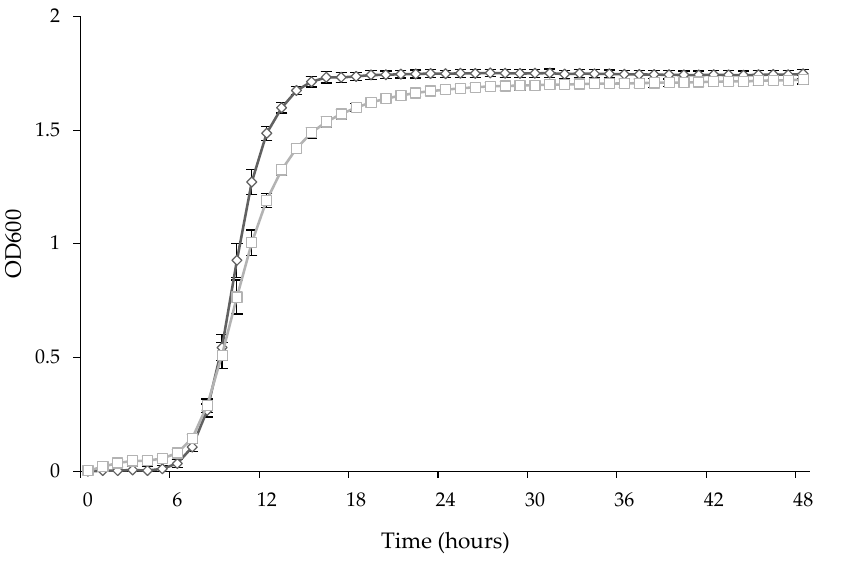
Figure 1. Growth curves of L. plantarum UFG 121 (square) and L. plantarum PAN01 (diamond). Data shown are mean ± SD (standard deviation) of three independent